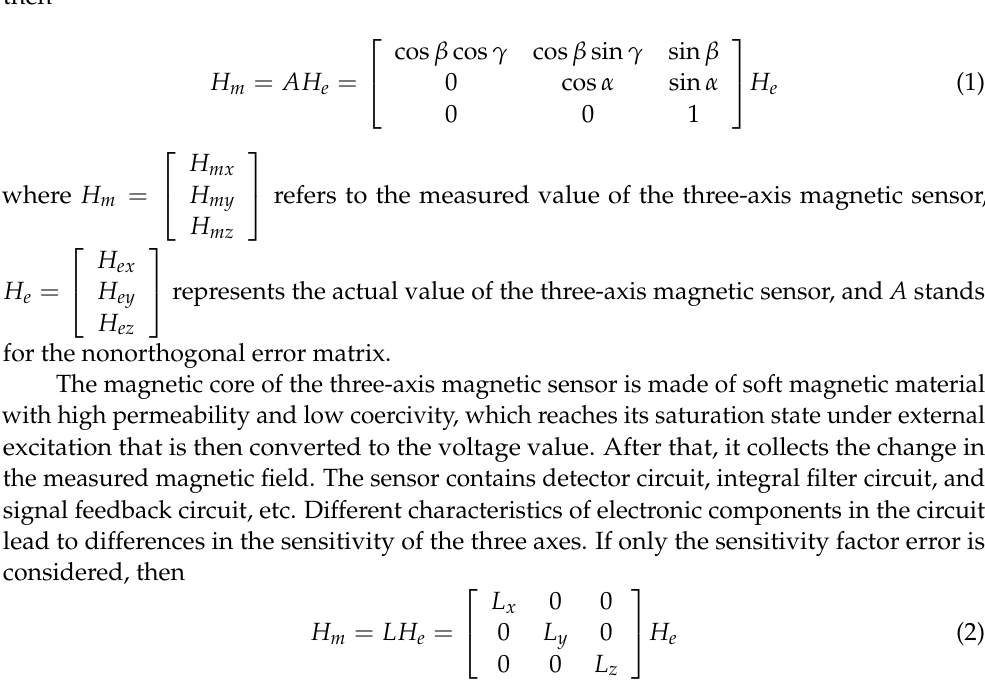
Figure 1. Nonorthogonal schematic diagram of three-axis magnetic sensor. Where α refers to the angle between the y axis and the y (cid:48) axis, β represents the angle between the x (cid:48) axis and the xoy plan, and γ stands for the angle between the projection of the x (cid:48) axis in the xoy plan and the x axis. If only the nonorthogonal error is considered, then